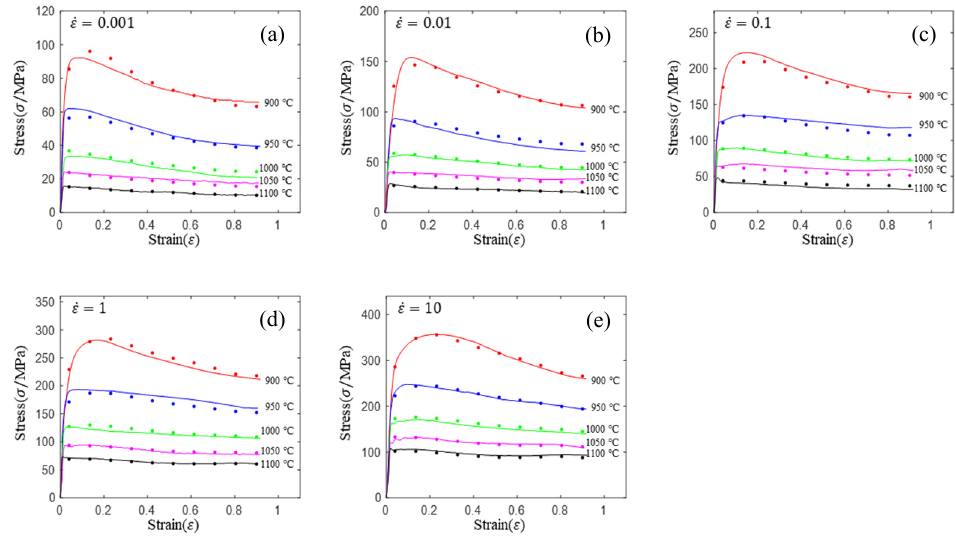
15 of 26 Figure 8. Linear regression values of material parameters at di ff erent strain levels and their polyno- mial fi tt ing for the quadratic model. The expression of each material parameter and strain can be obtained by fi tt ing the data points of linear regression with a fi fth-order polynomial. Then, the expression of each material is shown in Equation (17).